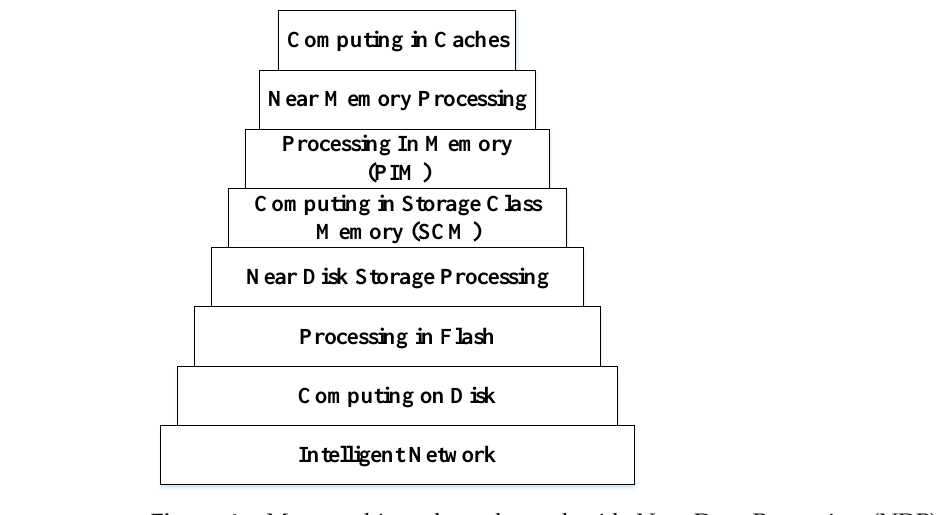
Figure 4. Memory hierarchy enhanced with Near-Data Processing (NDP) capacity (adapted from